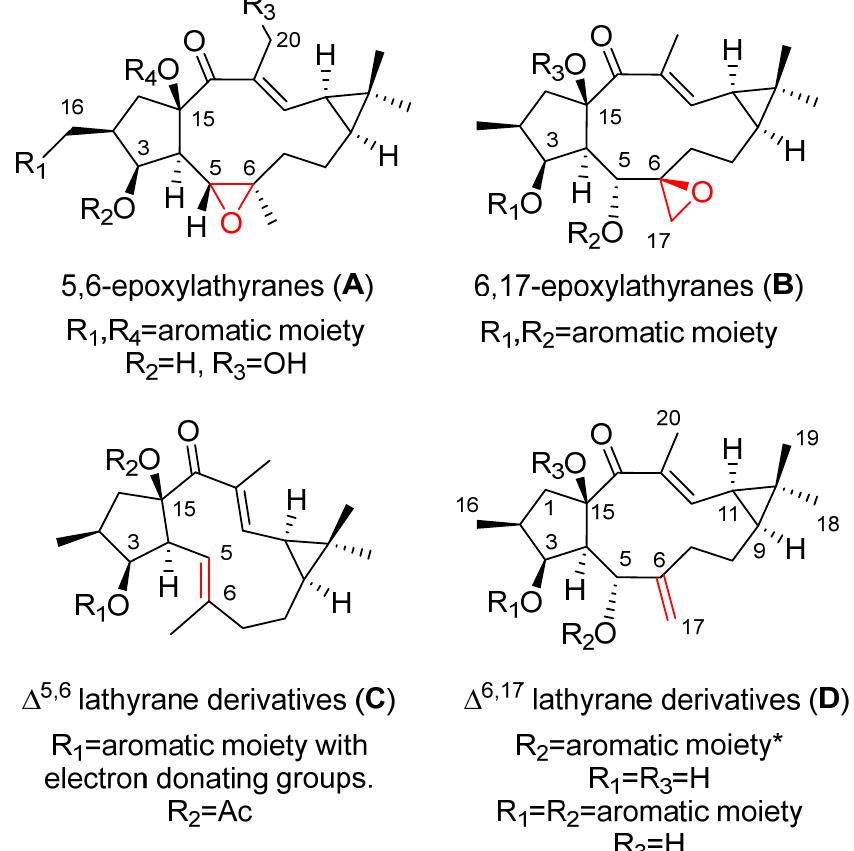
Figure 2. Functionalization patterns in active compounds evaluated for MDR. ( A ) Functionalization patterns in 5,6-epoxylathyranes; ( B ) Functionalization patterns in 6,17-epoxylathyranes; ( C ) Functionalization patterns in ∆ 5,6 lathyranes; ( D ) Functionalization patterns in ∆ 6,17 lathyranes. As discussed in the text, these are not absolute rules, as exceptions are observed. Both conformation of lathyrane macrocyclic scaffold and substitution patterns are determinants for MDR activity [22]. * Electron withdrawing groups and steric hindrance is detrimental for the activity of compounds evaluated against drug efflux transporters in Candida albicans .